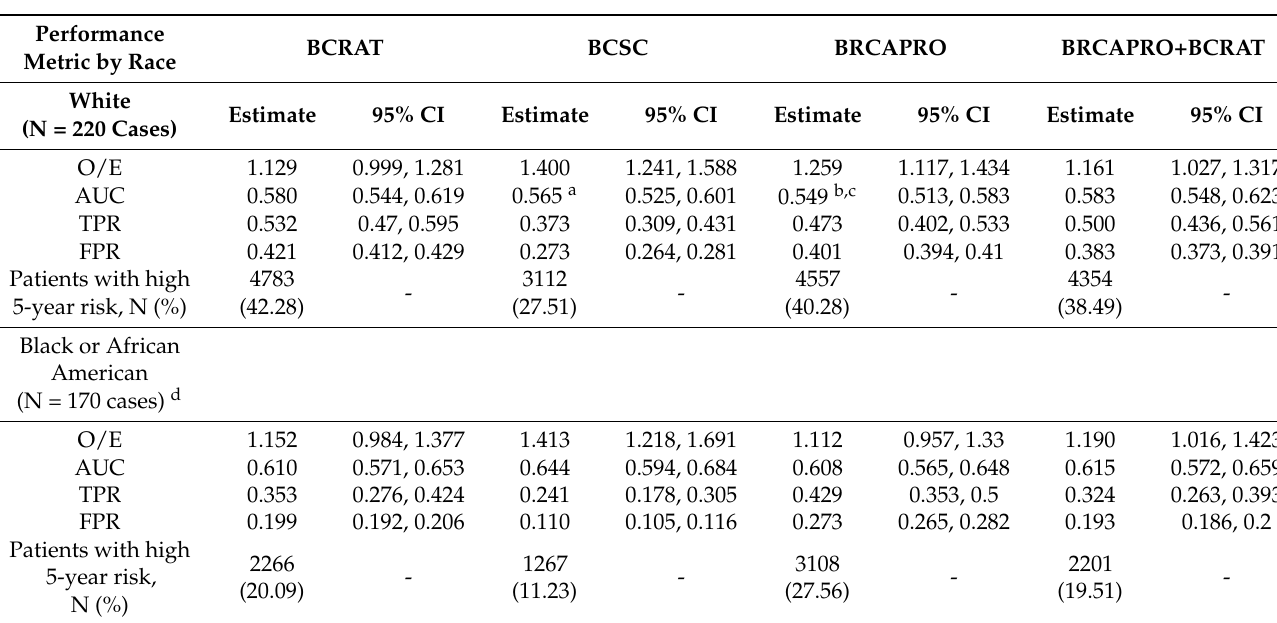
Table A2. Performance of risk models by race/ethnicity at